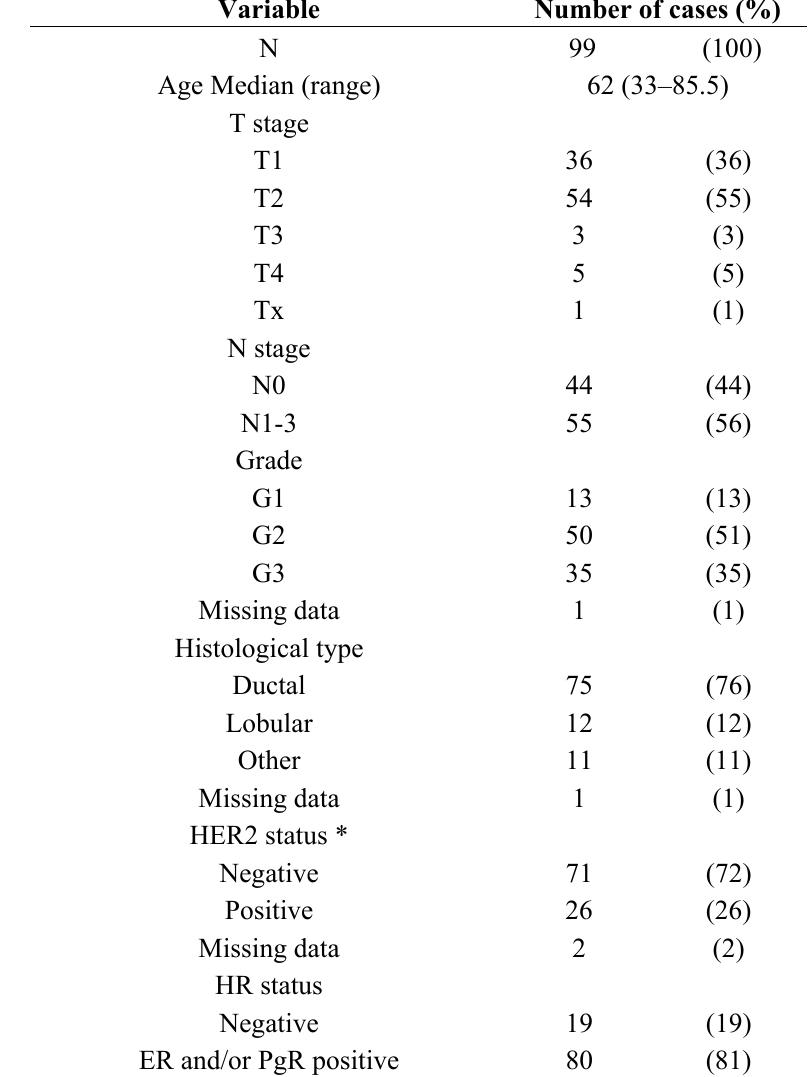
Table 8. Patients’